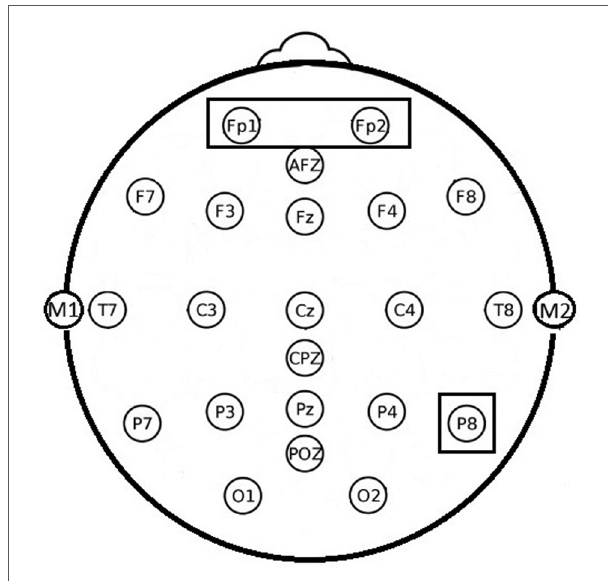
FIGURE 4 Electrode positions used for EEG recordings. Note the highlighted positions Fp1, Fp2 and P8 were experimental effect were